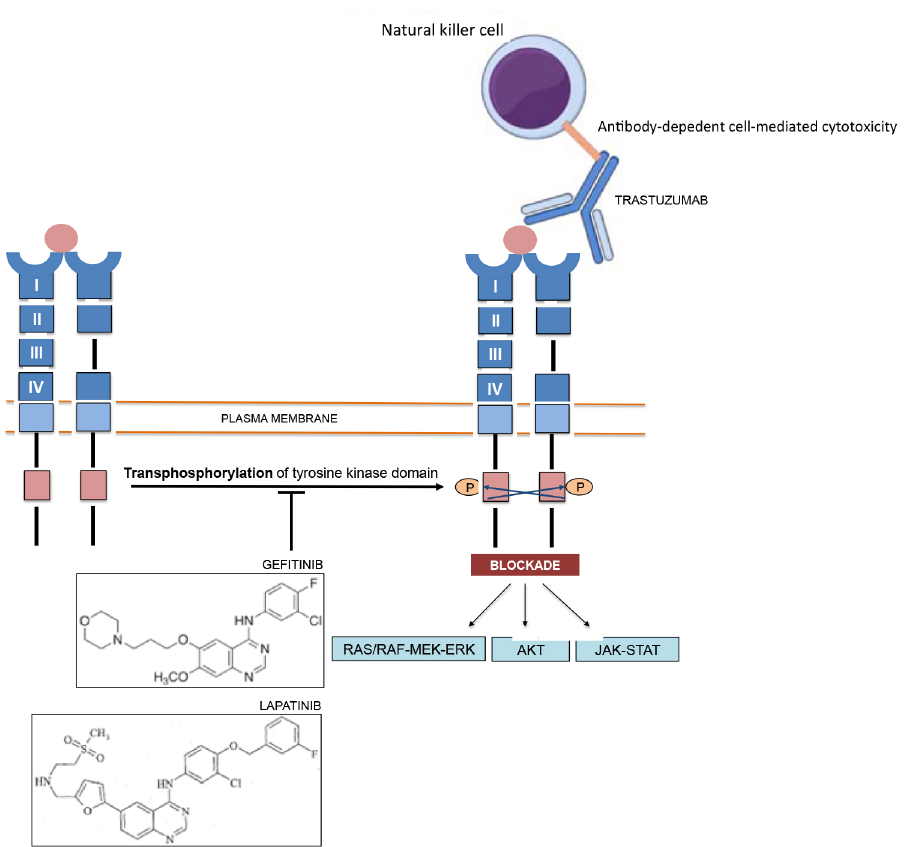
FIGURE 5 - Mechanisms of action of the two classes of drugs against HER receptors that have reached clinical phases: monoclonal antibodies (trastuzumab) and tyrosine kinase inhibitors (TKIs) (gefitinib and